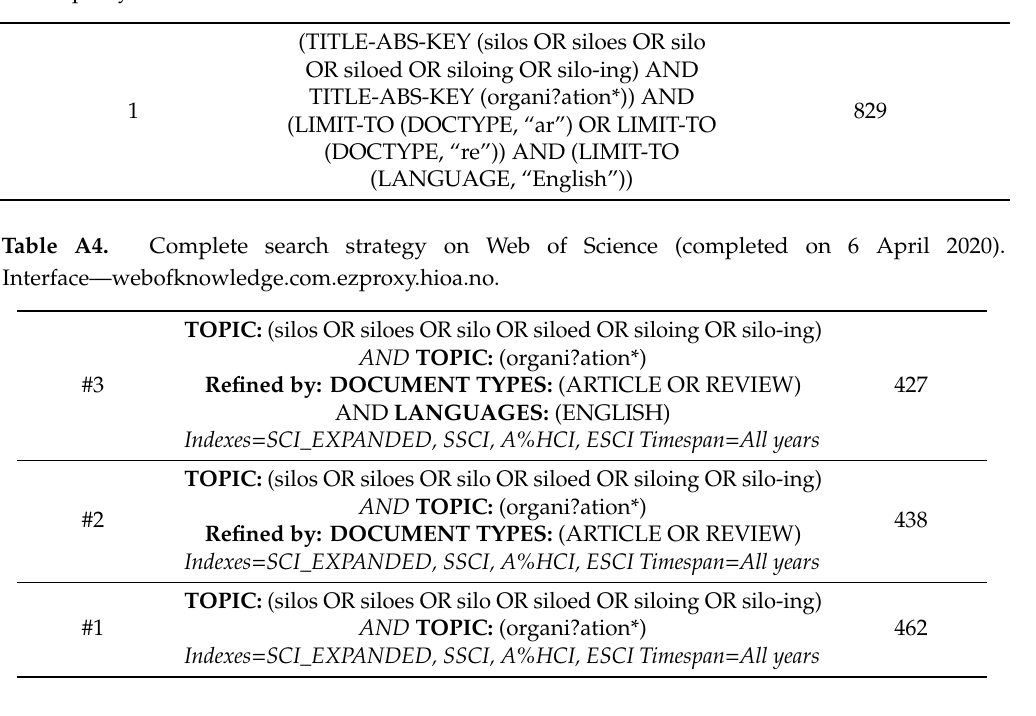
Table A3. Complete search strategy on Scopus (completed on 6 April 2020). Interface—scopus- com.ezproxy.hioa.no.